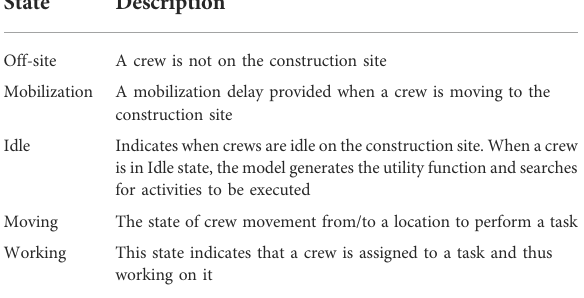
TABLE 2 Behavioral states for each crew